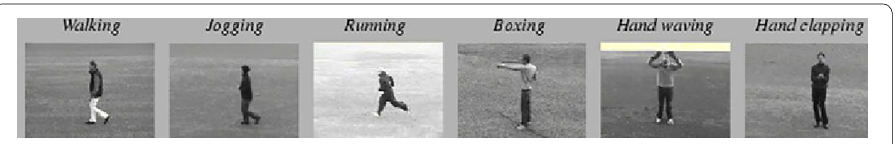
Fig. 6 Human actions in KTH